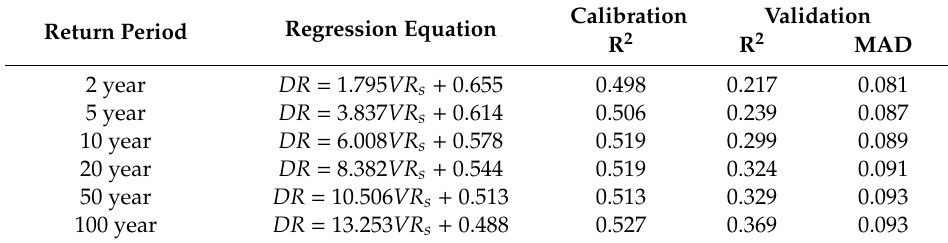
Table 4. The regression models between DR and VR s derived from 13 drainage networks in the calibration group for the six typical rainfall scenarios. The model performances in calibration and validation are also